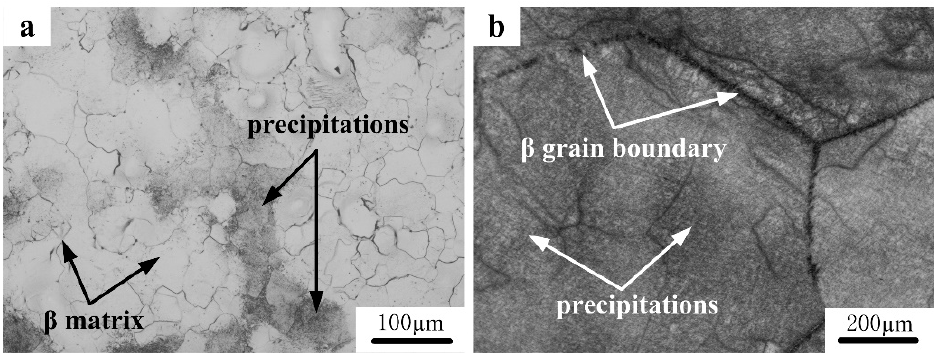
Figure 1. Initial microstructures of the Ti-5553 alloys: ( a ) As-consolidated powder metallurgy (PM) alloy; and ( b ) as-cast ingot metallurgy (IM) alloy.